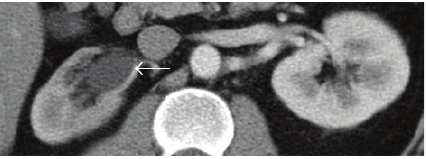
Figure 3: CAT scan axial view shows hydronephrosis (arrow) in right kidney.